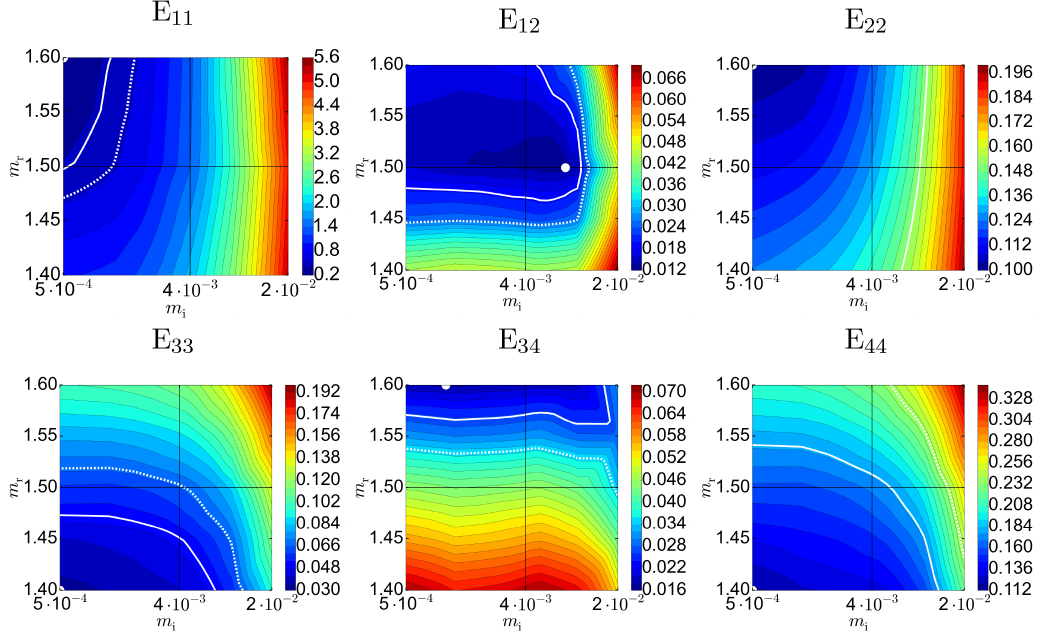
Figure 4. Scattering error E ij , similarly to Fig. 3, for different scattering matrix elements for the particle ensemble of Cal, Dol and Agg, when the ellipsoid shape distribution is fixed to be uniform, with equal weights for each